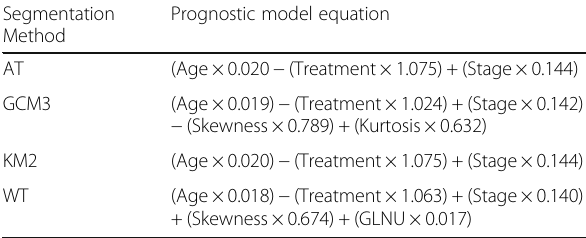
Table 5 Prognostic model